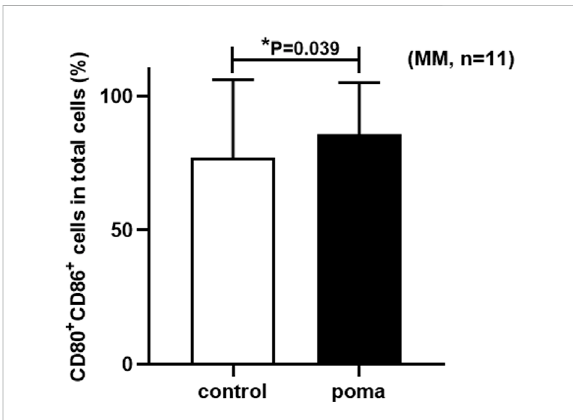
The comparison of the proportion of CD80 + CD86 + cells in total cells between the pomalidomide group and the control group in MM